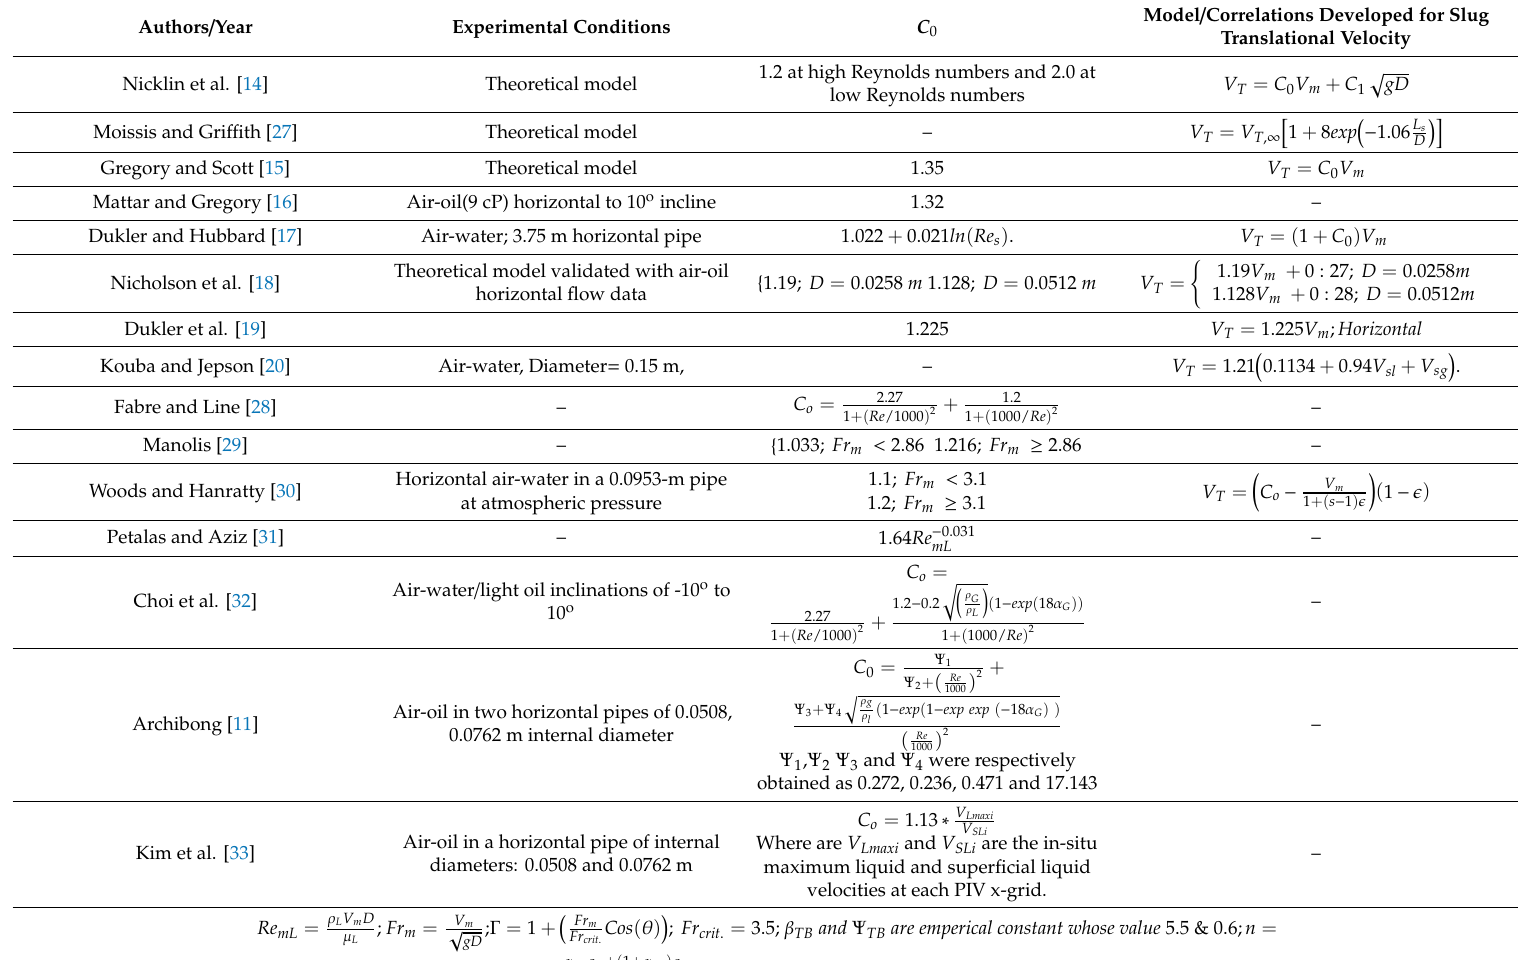
Table 1. A summary of current models in the open literature for slug translational